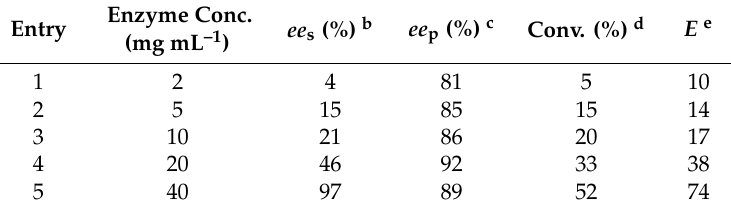
Table 4. E ff ect of enzyme concentration at 45 ◦ C in the hydrolysis of ( ± )-3 a a . Enzyme Conc. Entry